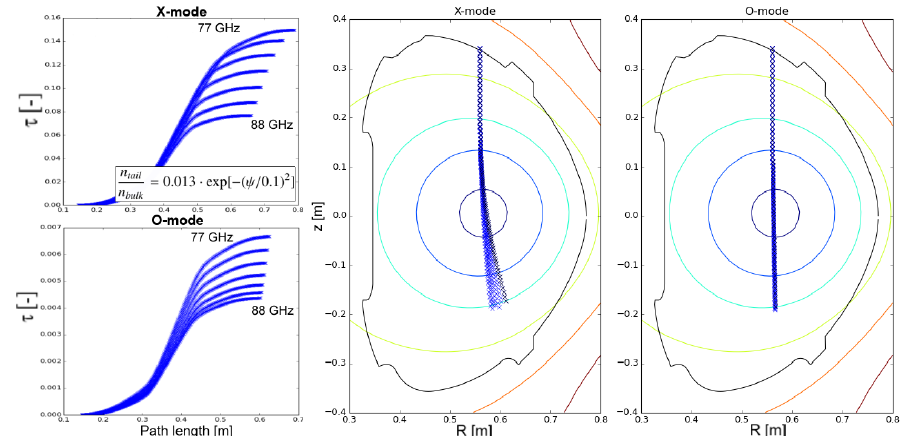
Figure 4. Left: Values of the optical depth τ dependent on the ray path length s for both O-mode and X-mode for E2-band frequencies. Center and right: Poloidal view of the trajectories of O-mode and X-mode rays in the COMPASS tokamak for odd E2-band frequencies, B = 1 . 15 T.